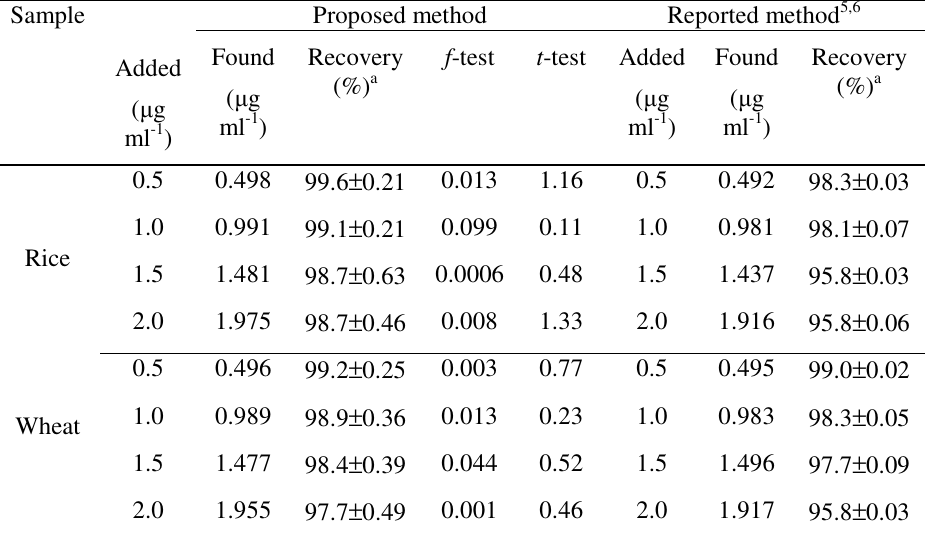
Table 3 Recovery of carbofuran from fortified grain samples using 4.4-azo-bis-3,3 ′ 5,5 ′ -tetra bromo